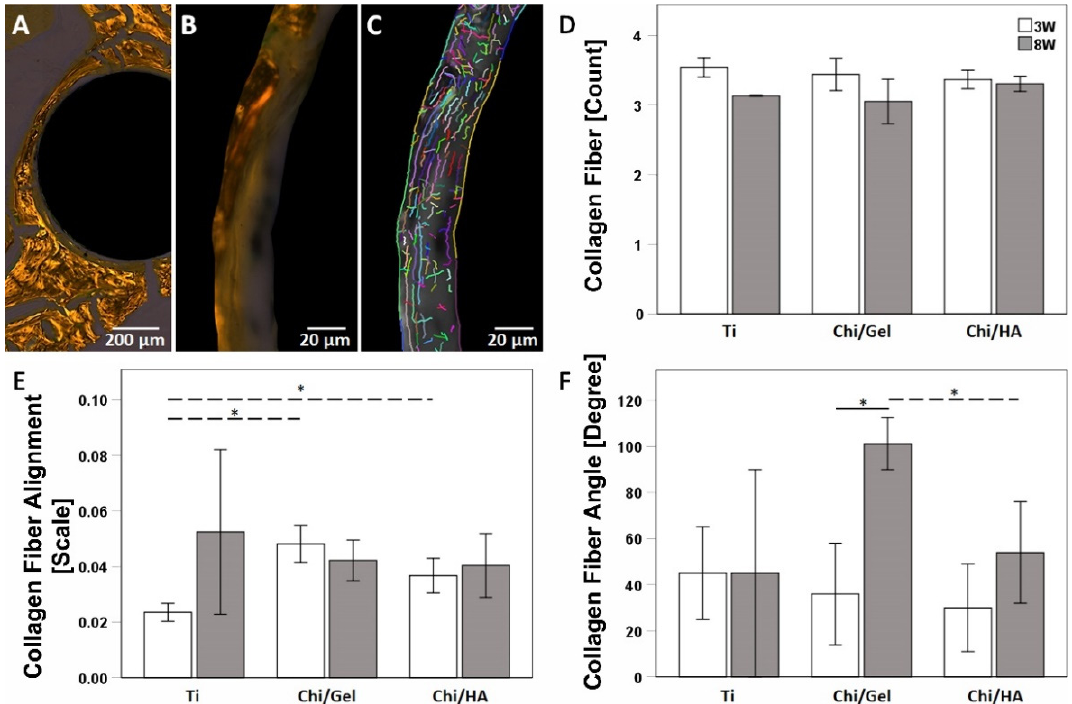
Figure 4. Collage fibers properties at the bone implant interface indicate bone matrix quality. ( A ) and ( B ) Sirius red-stained images were used to visualize collagen type around the implant. ( C ) collagen fibers properties were investigated on monochromic pictures using CT-FIRE software. ( D ) Number of collagen fibers was less at 8 W without significant difference to 3 W. ( E ) Fiber alignment was highest in the Chi/Gel group at 3 W, with progression of tissue maturation no significant change in fiber alignment was seen in any group. ( F ) Orientation angle of fibers was around or below 50°, at all time-points in all groups. (Ti: n = 5 (3 W), n = 3 (8 W); Chi/Gel: n = 5/time point; Chi/HA: n = 4 (3 W), n = 5 (8 W), * : p ≤ 0.05 ).